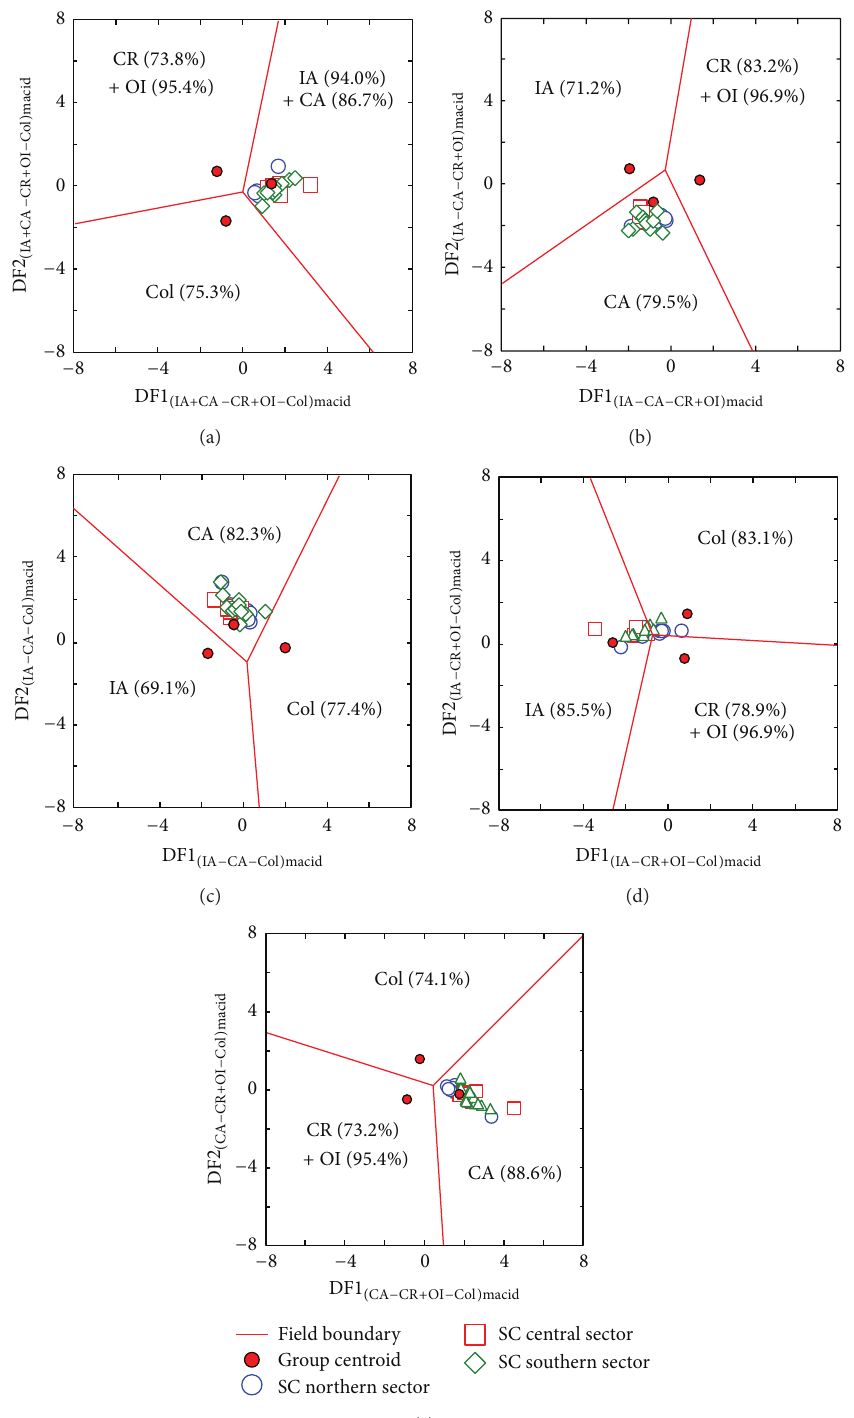
Figure 6: Discriminant-function multidimensional diagrams [22], based on ln-transformed ratios of major elements, for the tectonic discrimination of acid Sierra de las Cruces rocks. Tectonic settings: IA: island arc, CA: continental arc, CR: continental rift, OI: ocean island, and Col: collision. The symbols are explained as inset in (a). In (a), five groups are represented as three groups by combining IA and CA as IA + CA and CR and OI as CR+OI. The other four diagrams ((b)–(e)) are for three groups at a time. The subscript “macid” refers to the set of multidimensional diagrams based on ln-transformed major element (m) ratios for acid (acid) magmas. Filled circles display the compositional centroid for each tectonic setting. The percentages in each field are the discrimination effectivity. The thick lines represent equal probability discrimination boundaries in all diagrams. The coordinates of the field boundaries and additional information are reported in